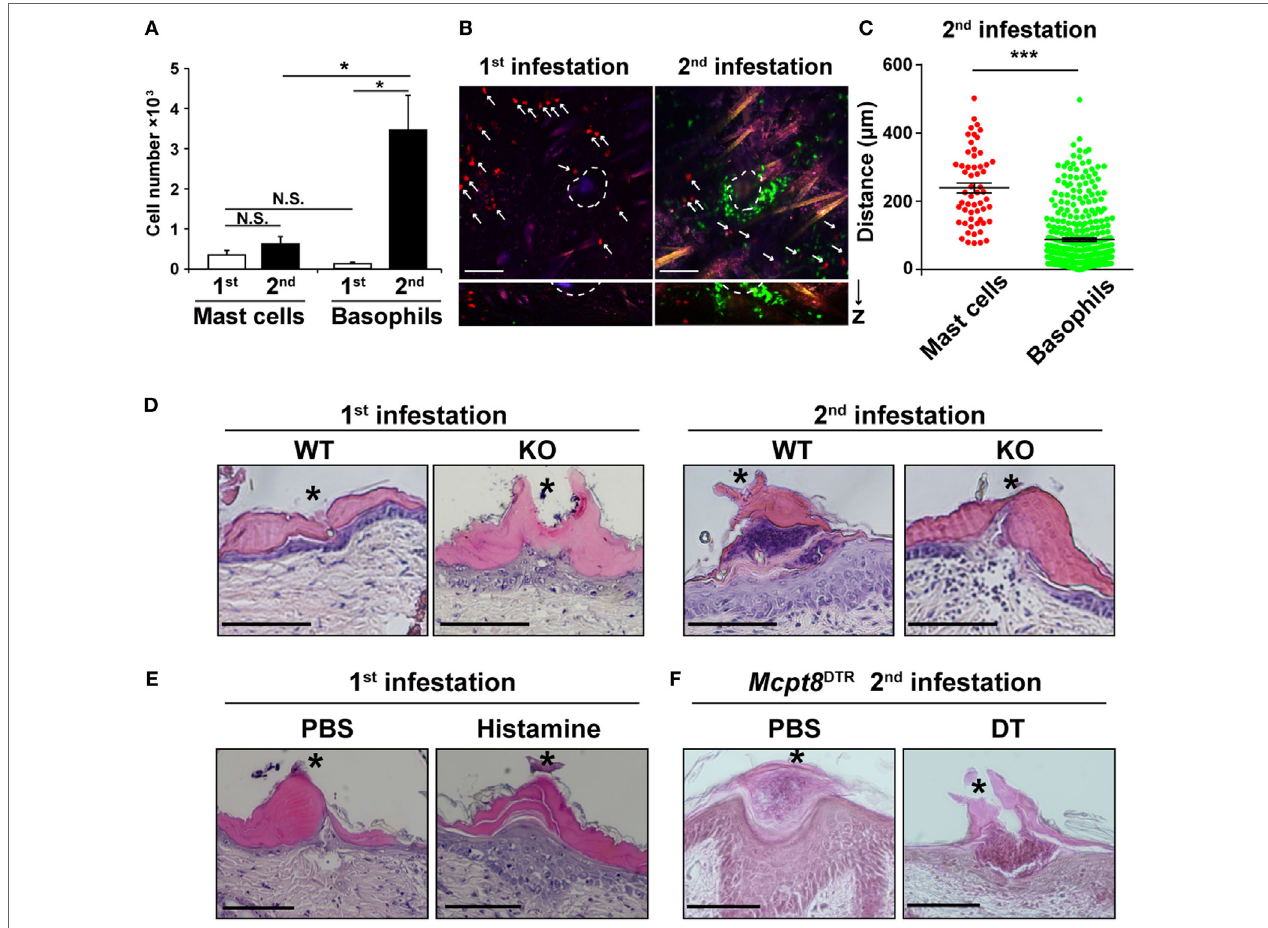
FigUre 4 | Basophils accumulate in larger numbers and at a position closer to tick mouthparts than do mast cells during the second tick infestation. (a) WT mice were infested once or twice with tick larvae. The numbers of basophils and mast cells (mean ± SEM, n = 4 each) accumulating at the second tick-feeding site on day 2 of the first or second infestation were examined by using flow cytometry. (B) Bone marrow-derived mast cell prepared from CAG-tdTomato transgenic mice were intradermally transferred into the right flank of Kit W-sh/W-sh Mcpt8 GFP mice. Recipient mice were infested once or twice with tick larvae as in Figure 3c and subjected to intravital imaging analysis of basophils (in green) and mast cells (in red, marked with white arrows) at tick-feeding sites on day 2 of the first or the second infestation. Upper pictures show the compilation of 12 horizontal images acquired from 0 to 100 μ m deep under the skin. Lower panels show vertical images of upper pictures. Dashed circular lines indicate sites where tick mouthparts were inserted into the skin. Scale bars indicate 100 μ m. (c) The distance of each basophil and mast cell away from the nearest tick mouthpart was measured in the images of the second tick-feeding site (mean ± SEM, 58 mast cells and 371 basophils were analyzed). (D) Skin sections of tick feeding sites in WT and histidine decarboxylase KO mice on day 2 of the first or second infestation were stained with hematoxylin and eosin. Asterisks indicate sites where tick mouthparts were inserted into the skin. Scale bars indicate 200 µm. (e) Histamine or control PBS was injected intradermally beneath the first tick-infested site once a day for 3 days, starting 1 day before the infestation. On day 2 of the first infestation, skin sections of tick feeding sites were stained with hematoxylin and eosin as in (D) . (F) Mcpt8 DTR mice were treated with diphtheria toxin or control PBS 1 day before the second infestation. Skin sections of tick feeding sites were stained with hematoxylin and eosin as in (D) . All the data shown in (a–F) are representative of at least three independent experiments. N.S., not significant; * p < 0.05; *** p <